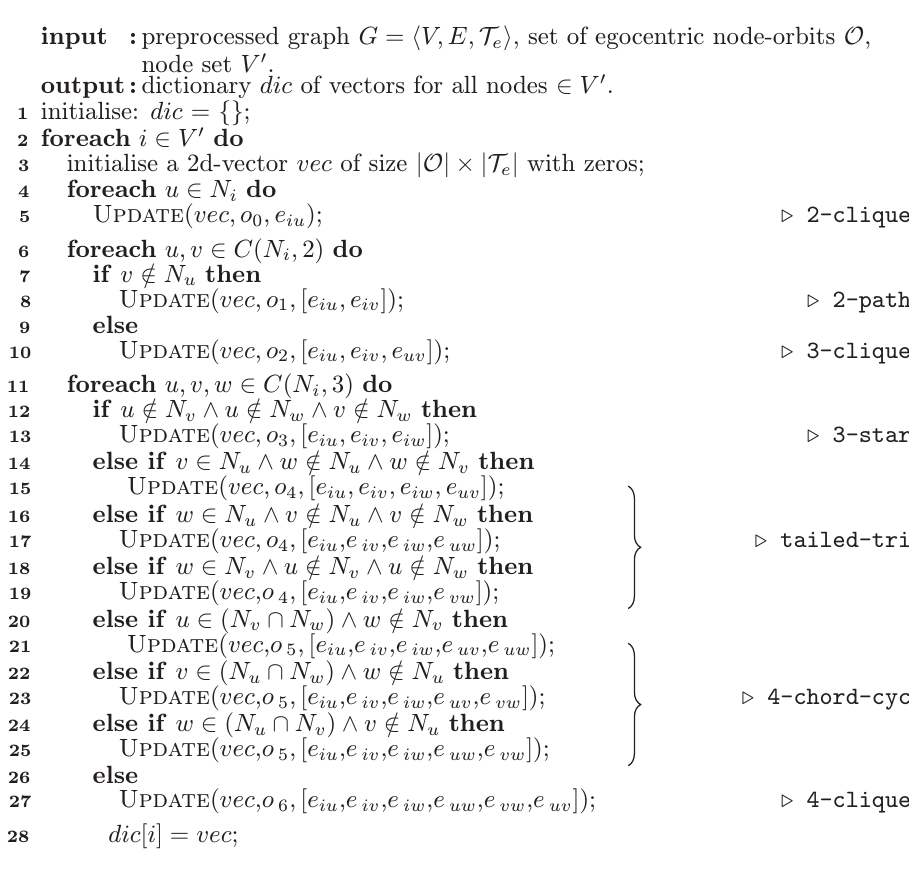
Algorithm 4: Build Typed-Edge Ego-Graphlet Degree